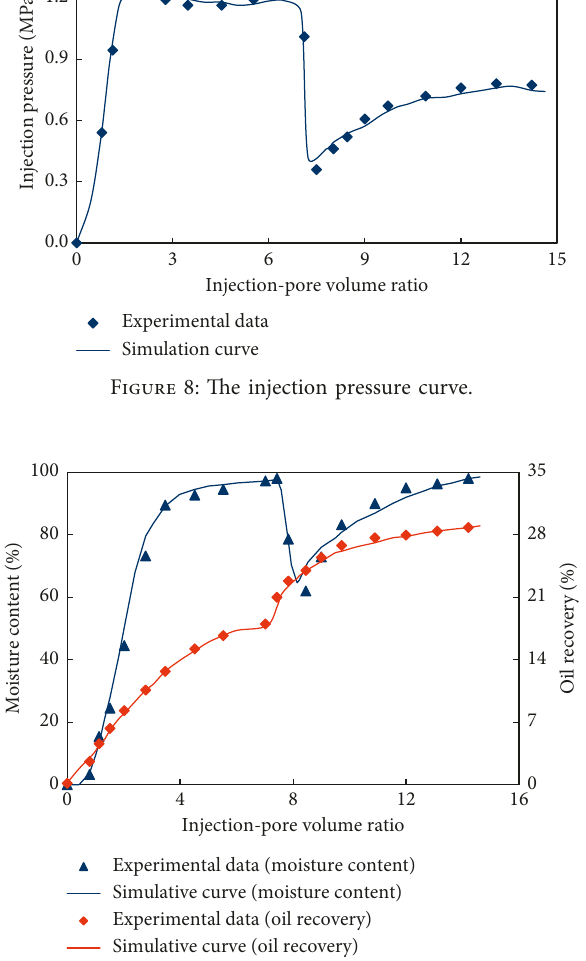
Figure 9: The moisture content and oil recovery